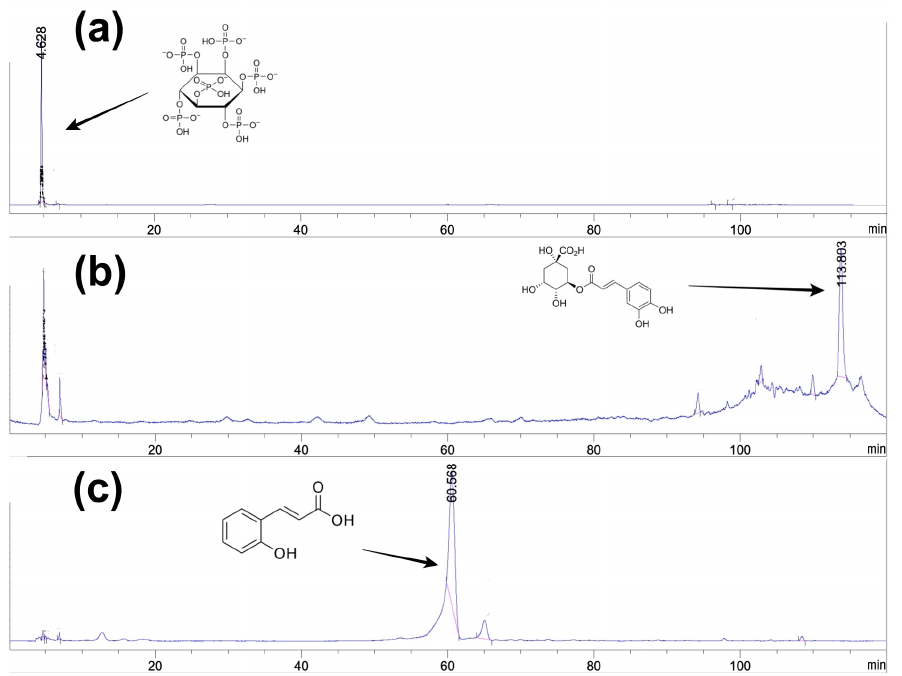
Figure 2. Liquid chromatography-mass spectrometry (LC-MS) chromatograms of ( a ) phytic acid, ( b ) chlorogenic acid, and ( c ) o -coumaric acid in Oryza sativa L. cv. Khao Dawk Mali 105 (KDML105) bran